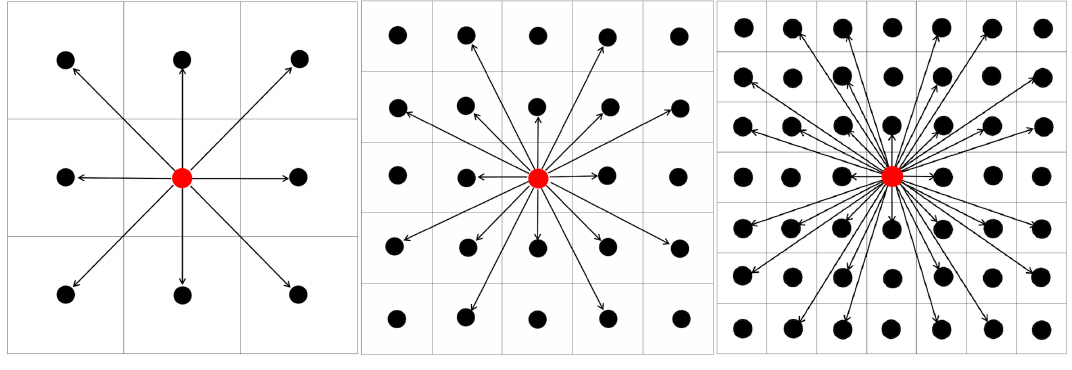
Figure 1. Adjacent nodes for